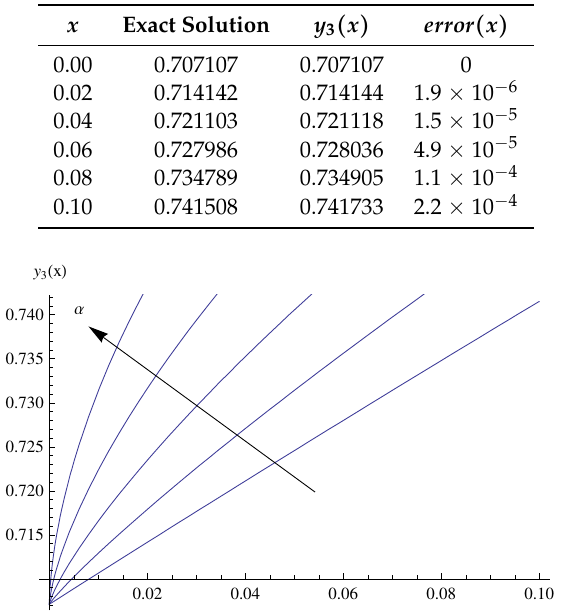
Table 2. Error when α = 1.